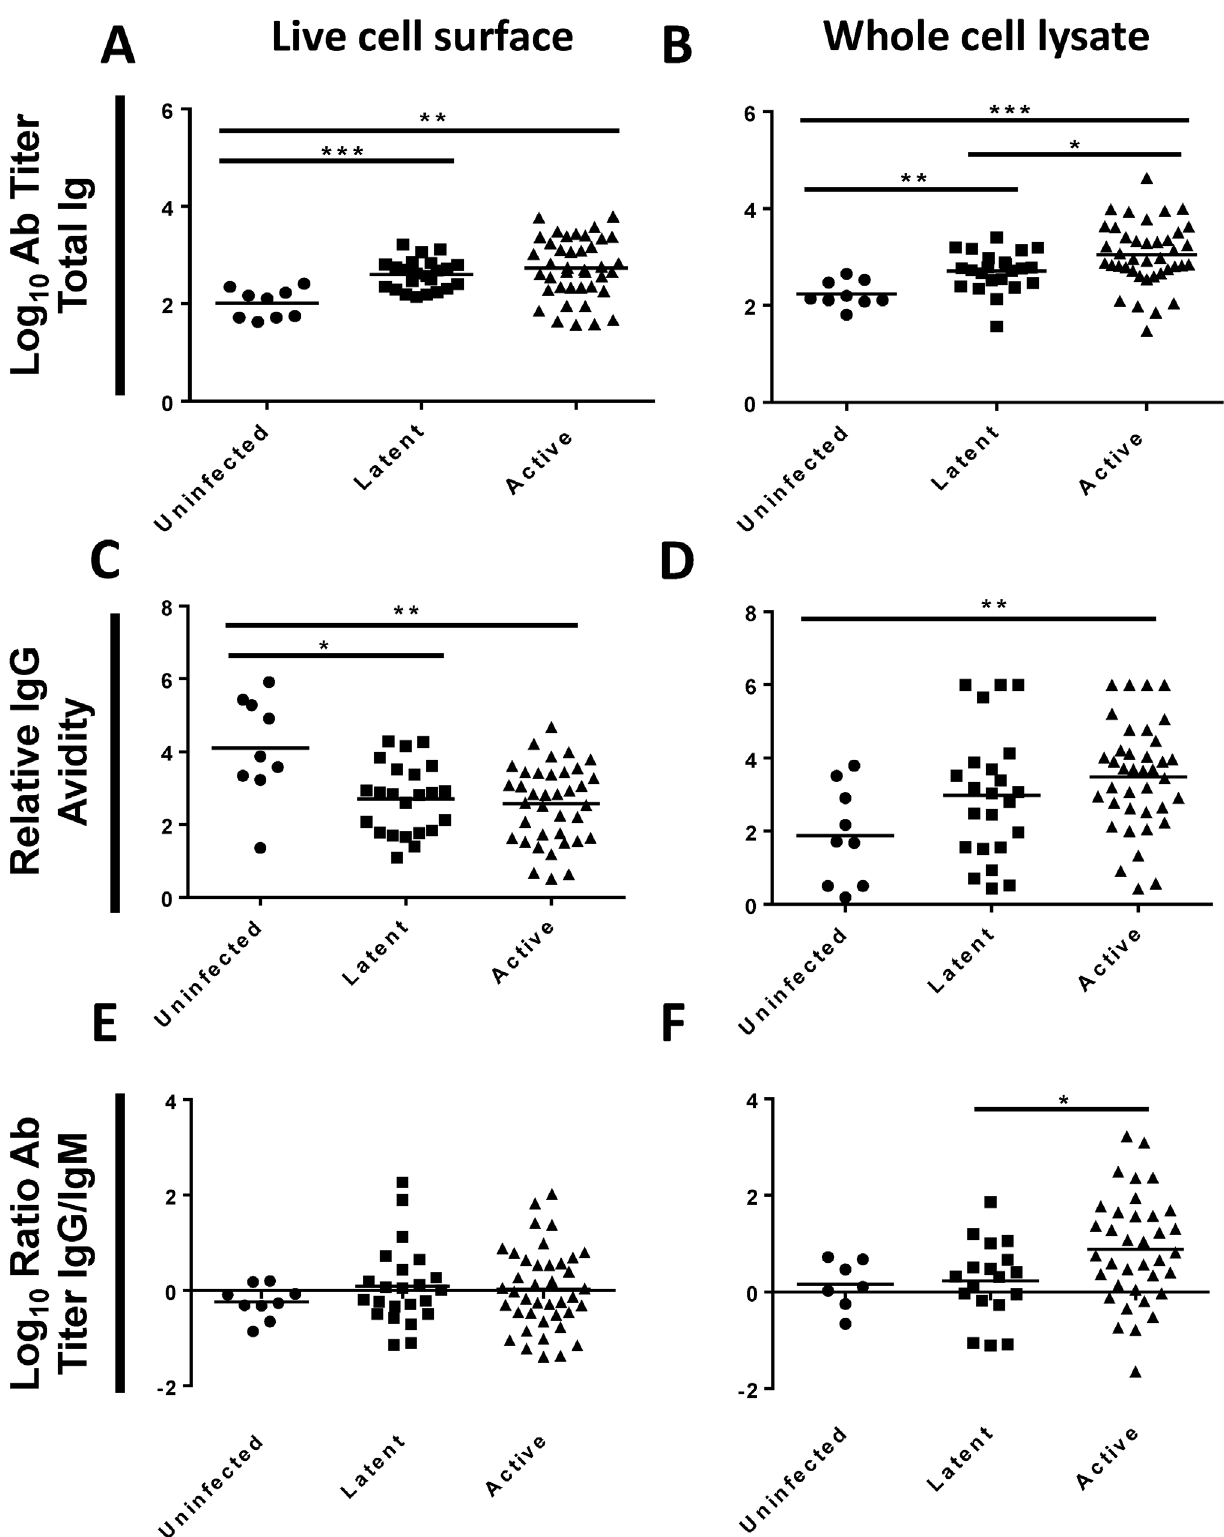
Figure 1. Antibody (Ab) responses to M. tuberculosis live cell surface or whole cell lysate. Plasma from PPD-negative volunteers (Uninfected), patients with latent TB infection (Latent), or patients with active TB disease (Active) were assayed by ELISA against the surface of live M. tuberculosis H37Rv or H37Rv whole cell lysate. ( A–B ) Log 10 total Ig titers. ( C–D ) Relative IgG avidity. ( D–E ) Log 10 ratio of IgG to IgM titers. Two-sided p-values by student’s t-test or Mann-Whitney test: (*) p # 0.05, (**) p # 0.01, (***) p # 0.001.